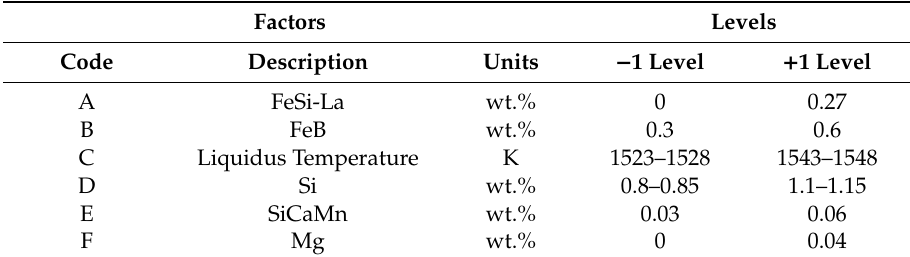
Table 2. Factors and levels analyzed in the design of experiments (DOE).